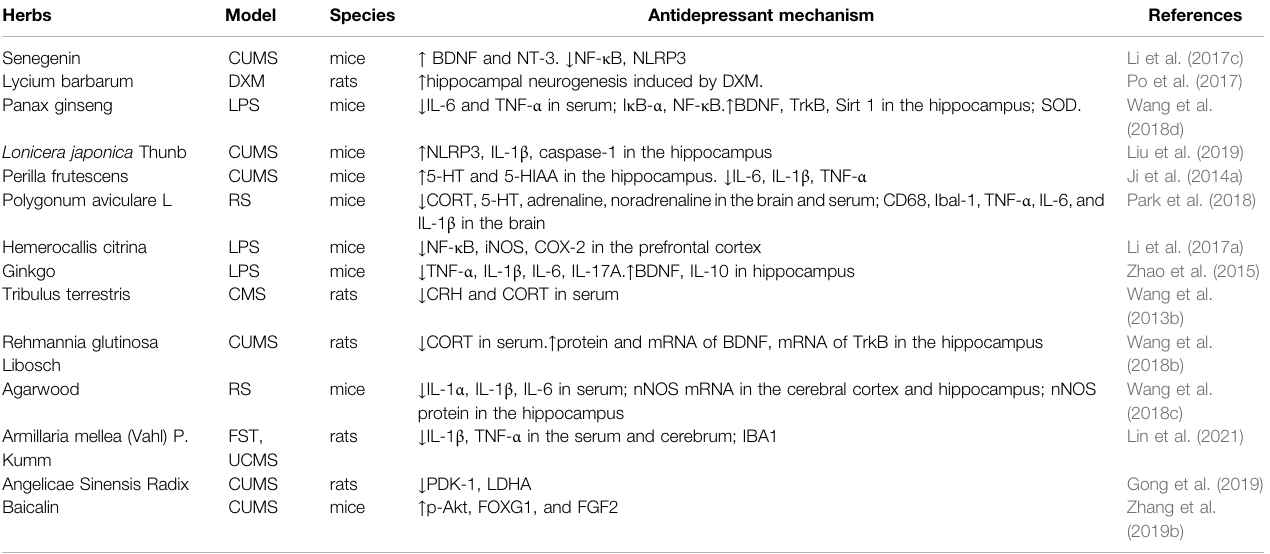
TABLE 3 | Antidepressant mechanism of herbs.